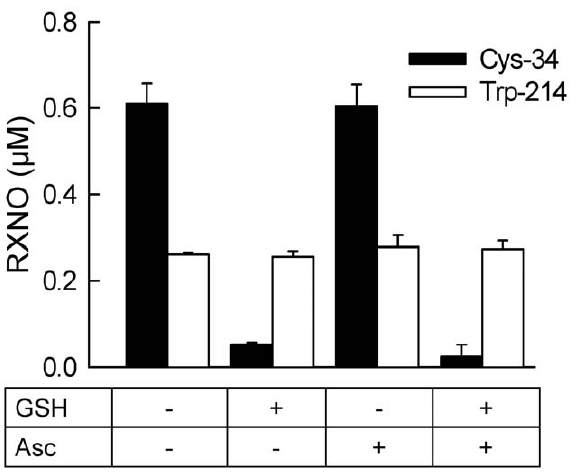
Figure 8. Stability of nitrosated human serum albumin in the presence of GSH and ascorbate. HSA (3 mg/ml) was incubated with 20 m M DEA/NO in 100 mM phosphate buffer (pH 7.4) containing 100 m M DTPA for 30 min at 37 u C. Samples were then incubated for an additional 30 min either alone or in the presence of GSH (1 mM) and ascorbate (Asc; 300 m M) in 100 mM phosphate buffer (pH 7.4) containing 100 m M DTPA, after which the samples were desalted. Nitrosation at Cys-34 and Trp-214 was then determined using reductive chemiluminescence. The values represent the mean 6 SEM (n=3).